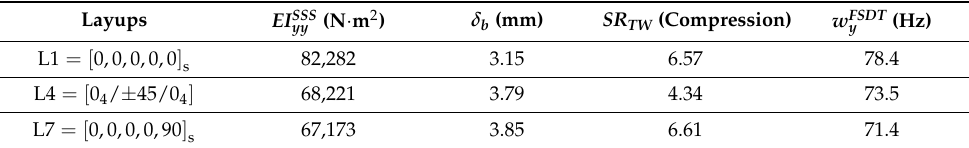
Table 7. Design criteria values for selected layups with the “SSS”